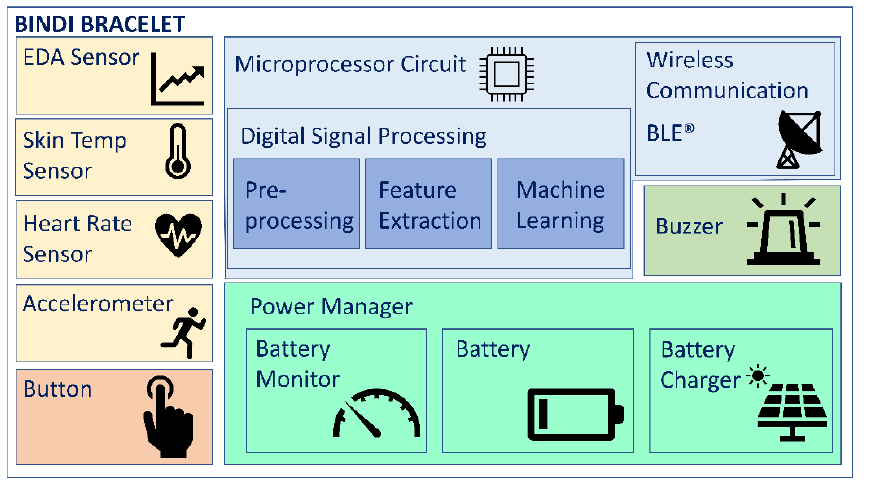
Figure 3. Bindi bracelet schematic.